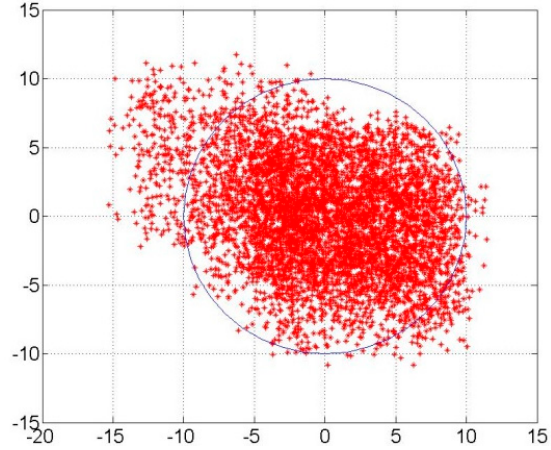
Figure 19. Positioning errors for the positioning experiment.